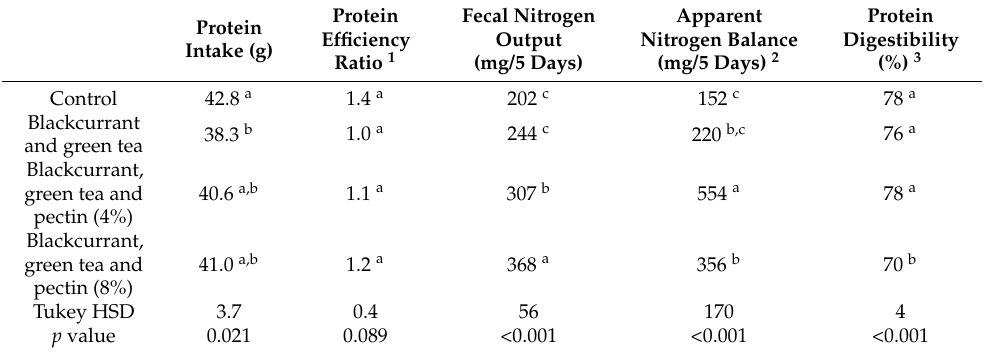
Table 3. Protein intake, fecal nitrogen and protein digestibility of rats fed the experimental diets.